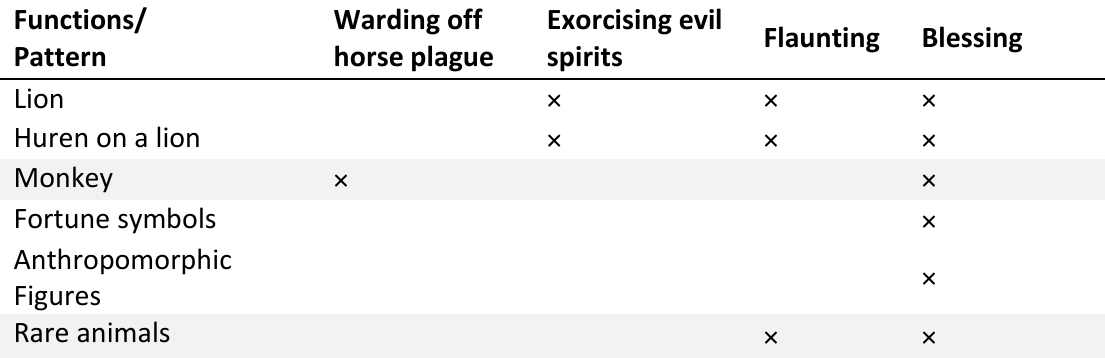
Table3. Symbolic functional comparison of different patterns